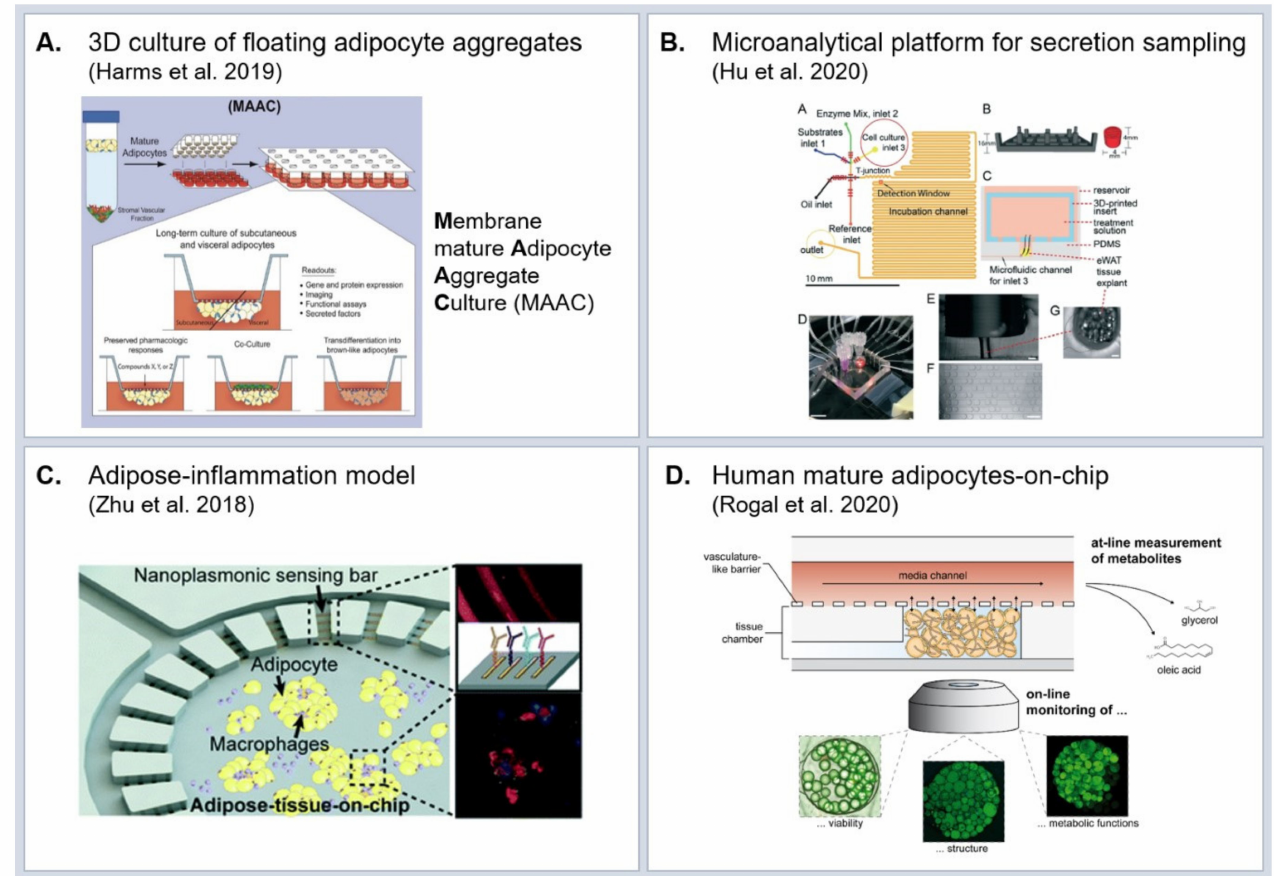
Figure 3. Adipose tissue in vitro models ( A ) Membrane mature adipocyte aggregate cultures (MAACs) enabling long-term culture of buoyant primary adipocytes. Reproduced and slightly modified from [160] (CC BY 4.0); ( B ) Microanalytical fluidic system for the monitoring of glycerol secretion from adipocytes at a 3.5 s temporal resolution. Reproduced from Ref. [164] with permission from The Royal Society of Chemistry; ( C ) Organ-on-chip for studying adipocyte-immune interaction with integrated biosensors for cytokine measurement. Reproduced from Ref. [165] with permission from The Royal Society of Chemistry; ( D ) Adipose-on-chip integrating human mature adipocytes into a micro-physiological environment featuring vasculature-like perfusion. Reproduced from reference [167] (CC BY